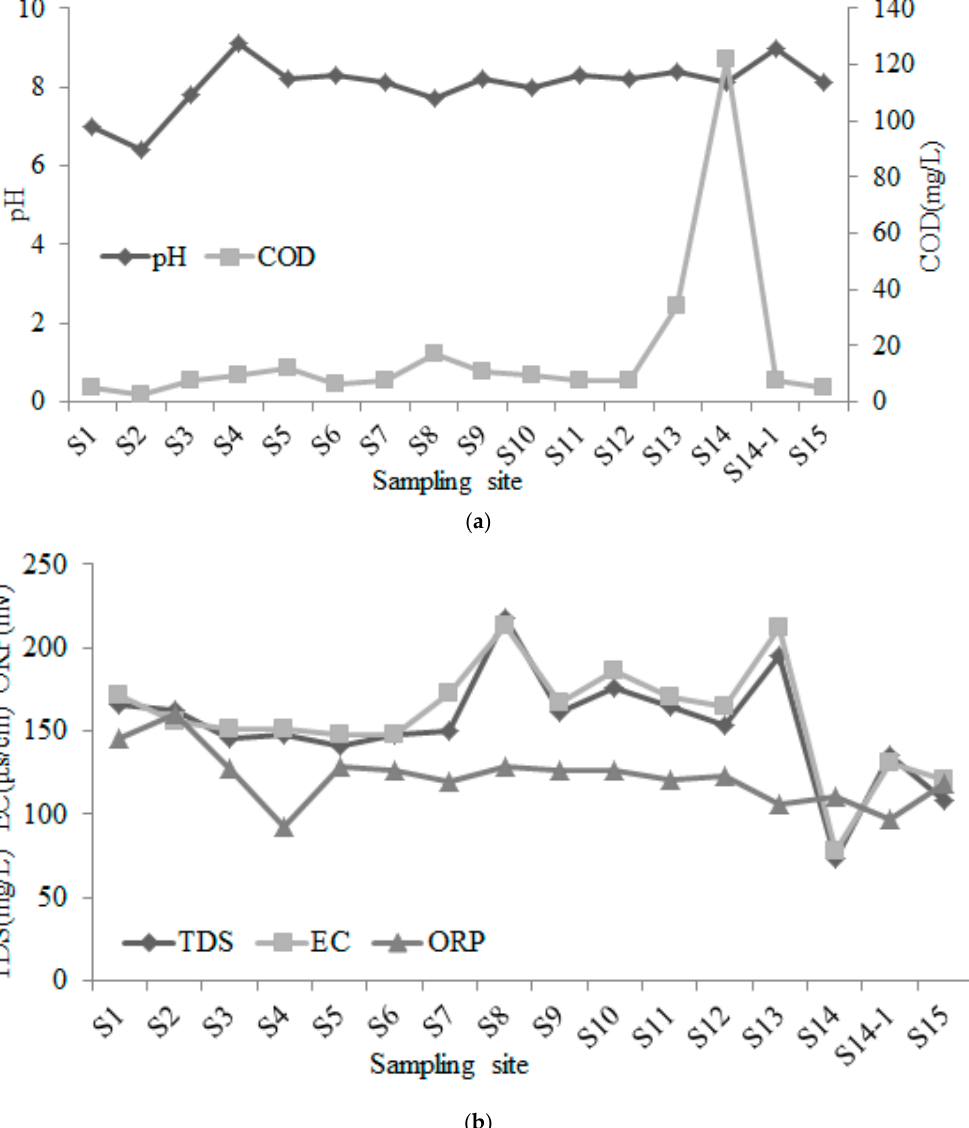
Figure 2. Variational chart of ( a ) pH and COD and ( b ) TDS, EC, and ORP in the Lhasa River.